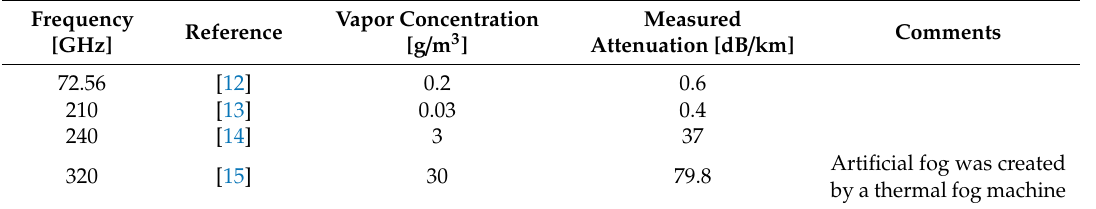
Table 2. Comparison of measured fog attenuation in millimeter wavelengths with previous